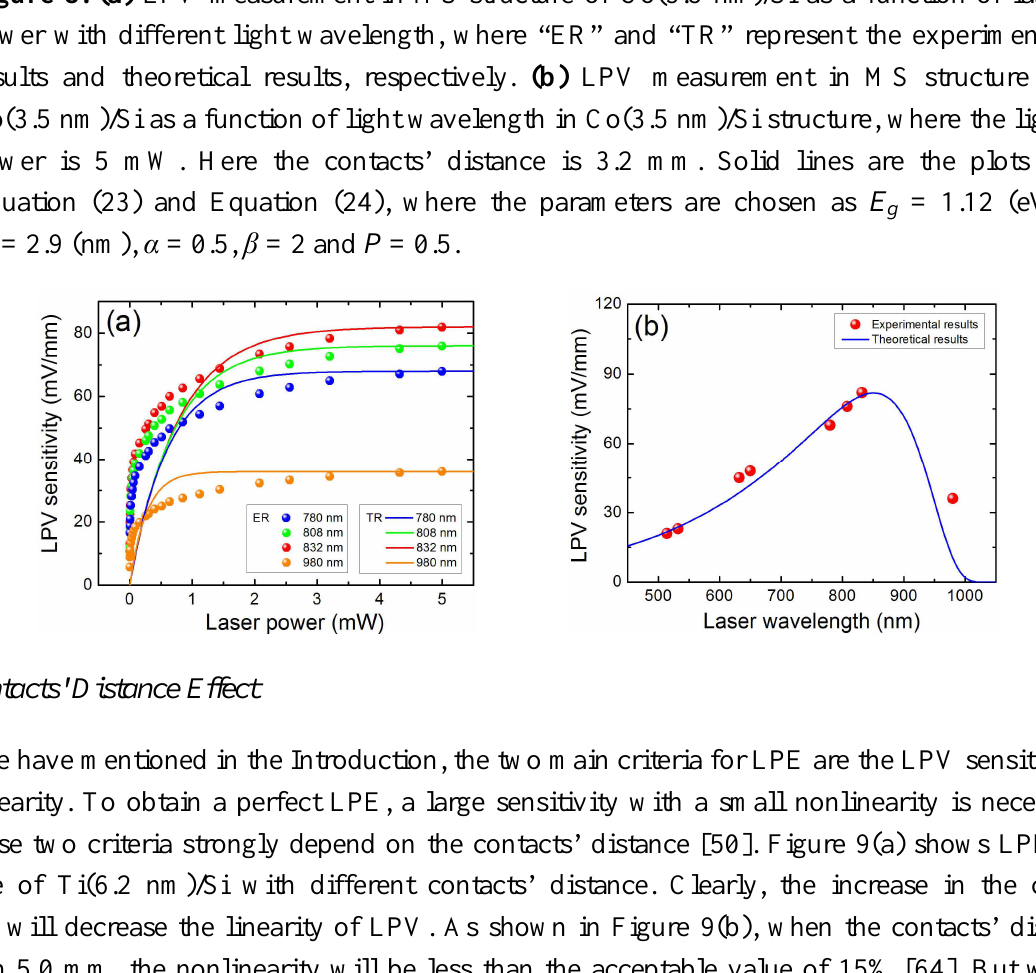
Figure 9. (a) LPV measurement in MS structure of Ti(6.2 nm)/Si with different contacts’ λ = 2.5 (nm). (b) LPV sensitivity and nonlinearity in MS structure of Co(3.5 nm)/Si as a m function of half contacts’ distance. Solid lines are the plots of Equation (12) and Equation (14), where the parameters are chosen as λ represent the experimental results and theoretical results, respectively. The laser wavelength and power are 632 nm and 3